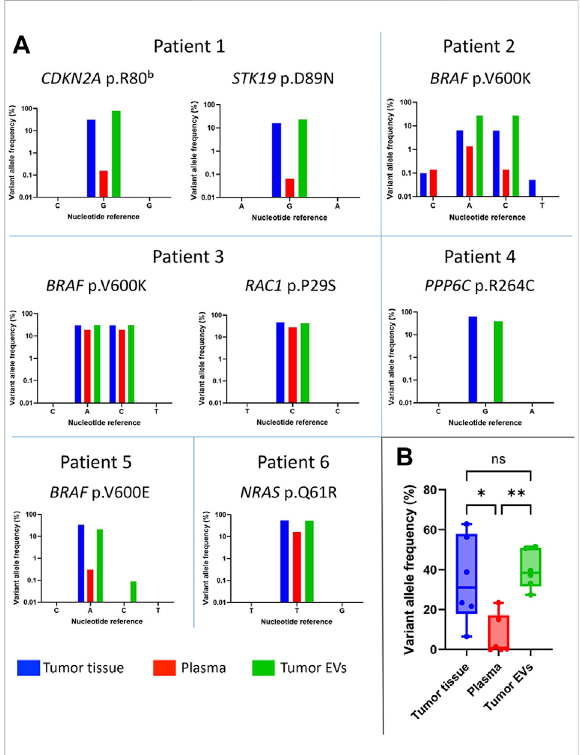
FIGURE 3 Mutantallelefrequenciesinmelanomapatients. (A) Frequencies of the mutated alleles detected in tumor tissue (blue), plasma (red), andtumor-derivedEVs(green)areshownperpatient (B) Visualization ofthemedianfrequencyofmutatedtumorallelesdetectedinall patients ( n = 6) per sample type. The allele frequency variations were considered signi fi cant with a p -value < 0.05 (* p < 0.05; ** p < 0.005). Graphs are shown in logarithmic